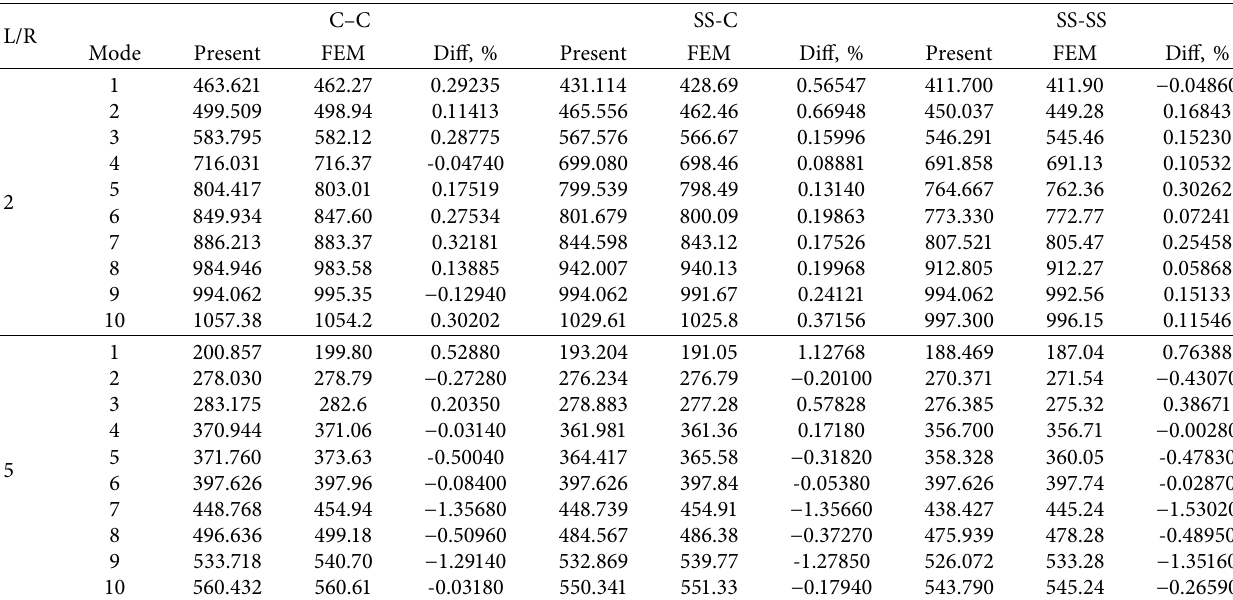
Table 5: Comparison of the first seven natural frequencies for composite laminated cylindrical shell with variable thickness. L/R